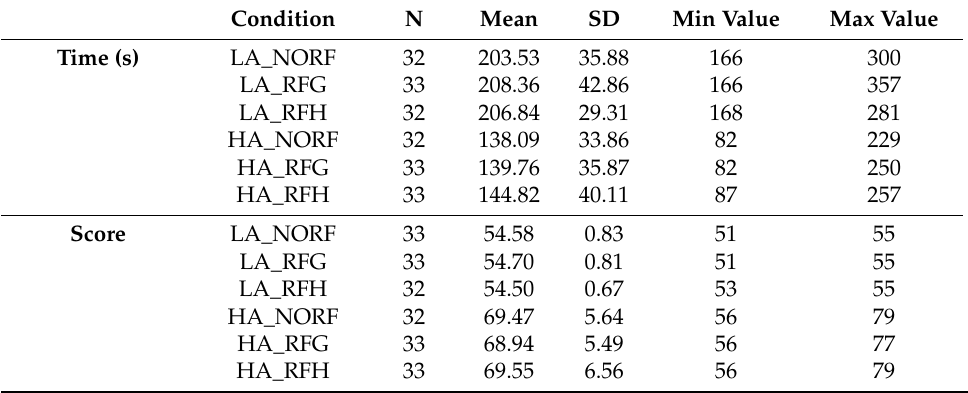
Table 11. Performance—score and time per